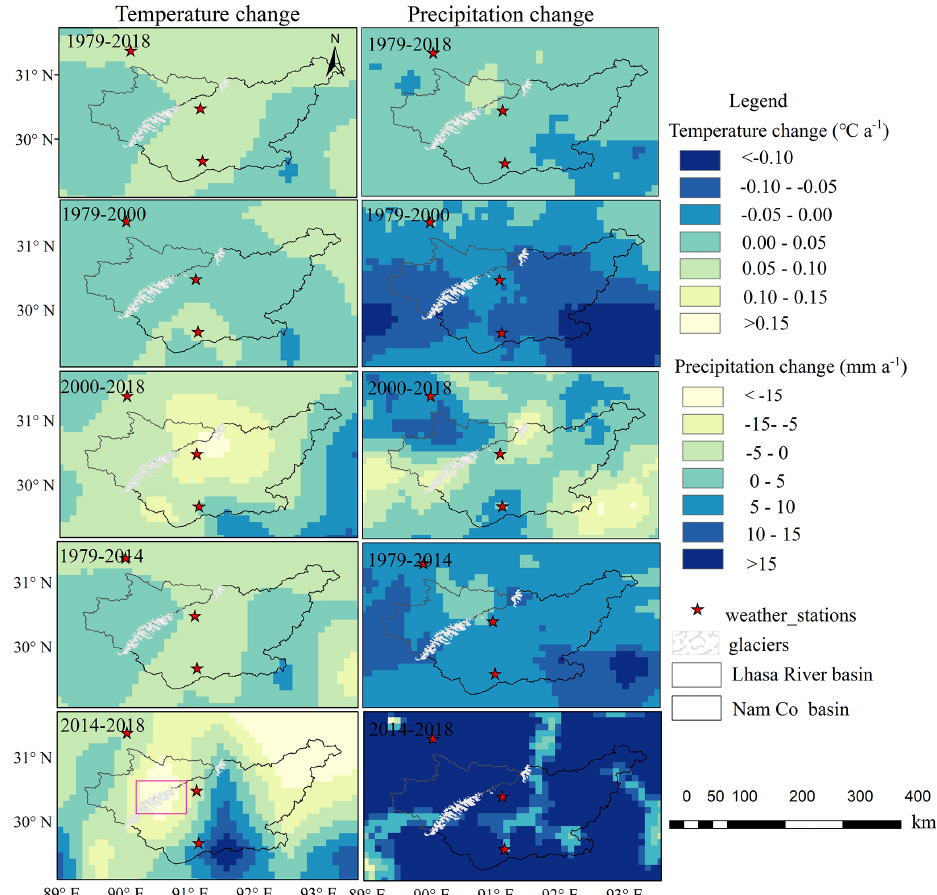
Figure 13. Gridded temperature and precipitation change during specific time